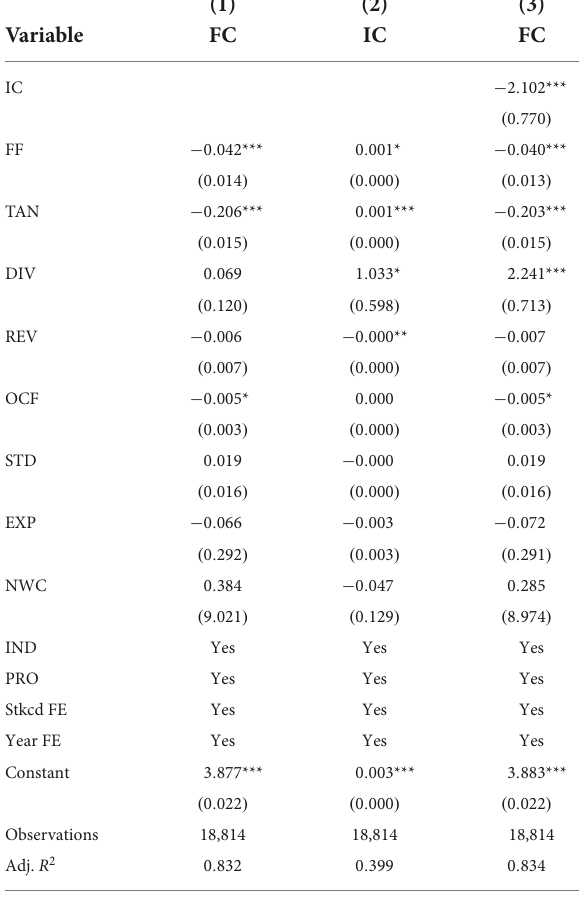
TABLE 5 Test of intermediary effect of investor